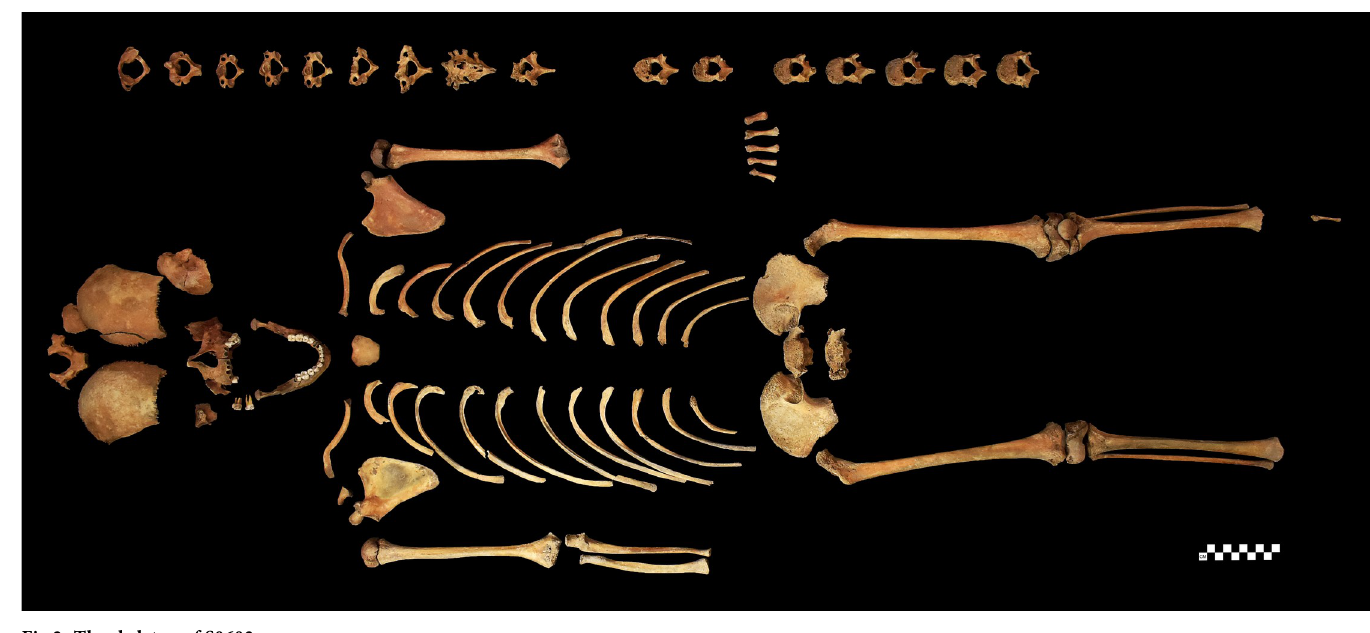
Fig 2. The skeleton of